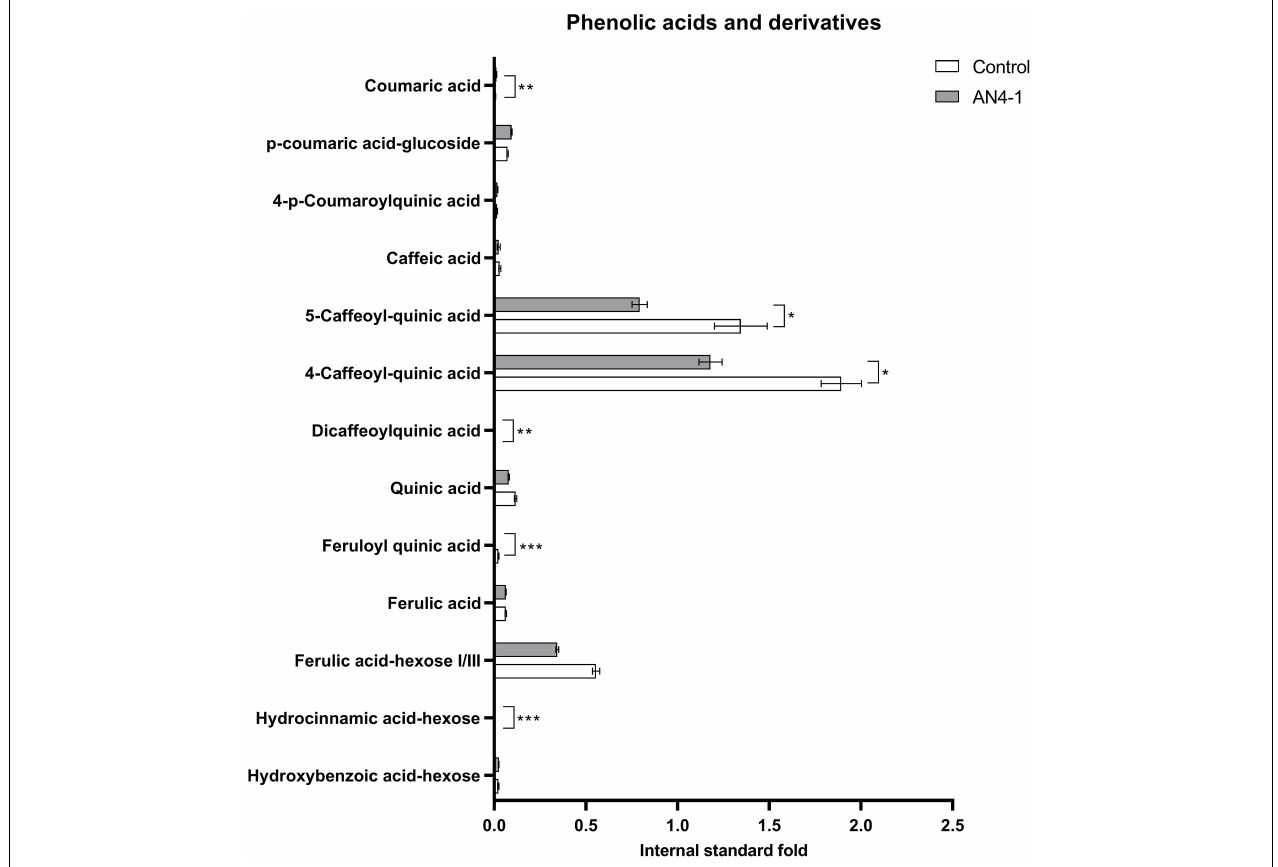
FIGURE 3 | Graph representing phenolic compounds and their derivatives expressed as internal standard (formononetin) fold of control and AN4-1 HRCs. Columns report average values ± SD ( n = 3). * p -value ≤ 0.05, ** p -value ≤ 0.01 and *** p -value ≤